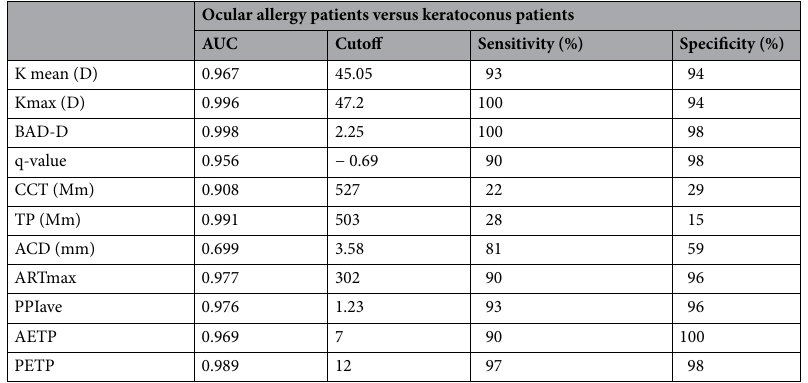
Table 6. Area under the receiving operator curve (AUC) for topographical parameters in a comparison between pediatric ocular allergy patients and pediatric keratoconus patients. Kmean mean keratometry, Kmax maximum keratometry, Astig astigmatism, CCT central corneal thickness, TP thinnest pachymetry, ACD anterior chamber depth, BAD-D Belin/Ambrosio enhanced ectasia display, ARTmax Ambrosio’s relational thickness maximum, PPIave average pachymetric progression index, AETP anterior elevation at the thinnest point, PETP posterior elevation at the thinnest point, PE maximum posterior